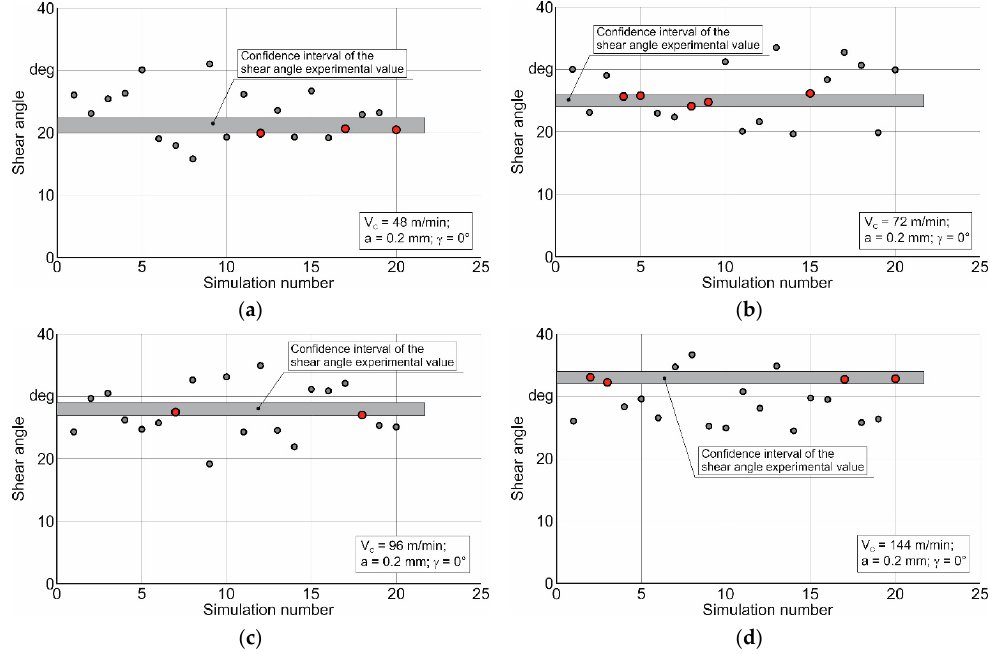
Figure 9. The first iteration of the simulated shear angle distribution relative to its experimental values for different cutting speed: ( a )—cutting speed 48 v/min; ( b )—cutting speed 72 m/min; ( c )—cutting speed 96 m/min; ( d )—cutting speed 144 m/min.